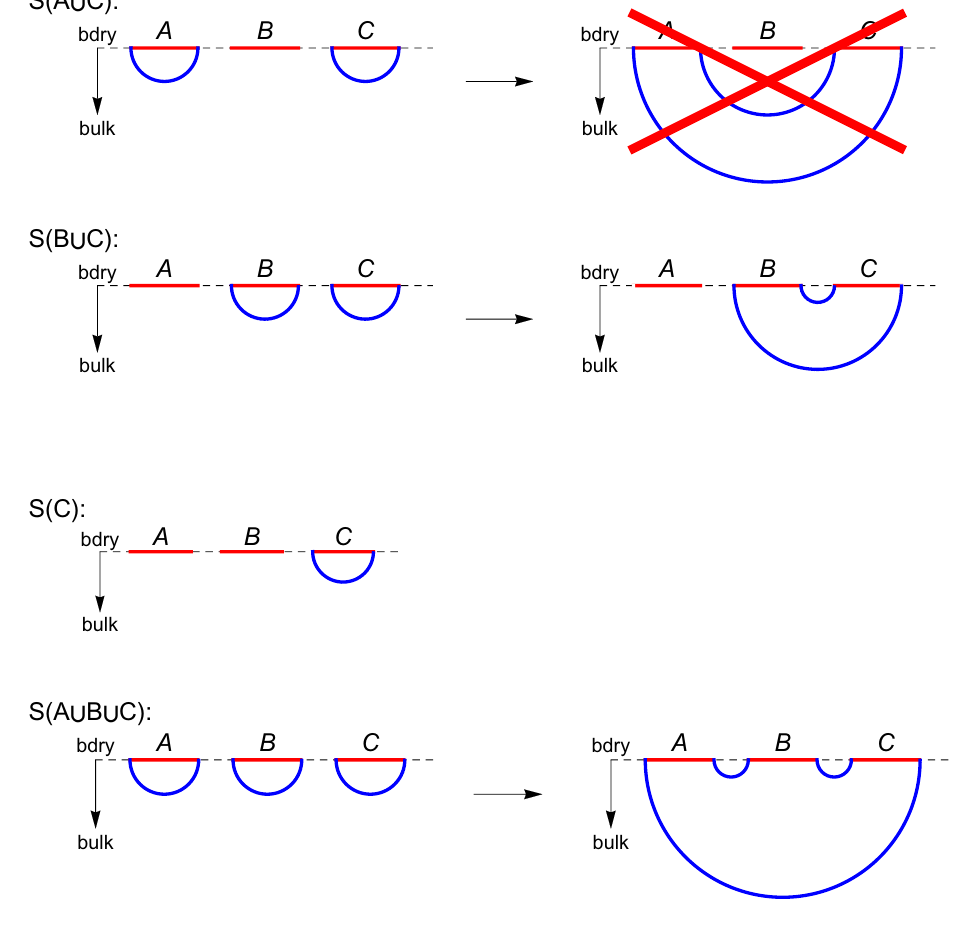
Figure 11 . Schematic of transitions in the entropies contributing to the conditional mutual infor- mation. Here, A , B , and C are strips of width l separated by gaps of width s . The blue arcs in (cid:12)gure shows the minimal surfaces in the holographic geometry that compute the entanglement entropy for the union of the indicated regions. The \disconnected" phases on the left occur when s=l is large enough. In these phases the the entanglement entropy of a union of regions equals the sum of the entanglement entropies of the regions separately. When s=l is small enough there is a transition to the \connected" phases indicated on the right. In the connected phases the entanglement entropy of a union of regions is not equal to the sum of the entanglement entropies of the regions separately because they share mutual information. The connected phase for S ( A [ C ) is crossed out since that phase never occurs in our case. This is because A and C are always separated by an interval of length at least l